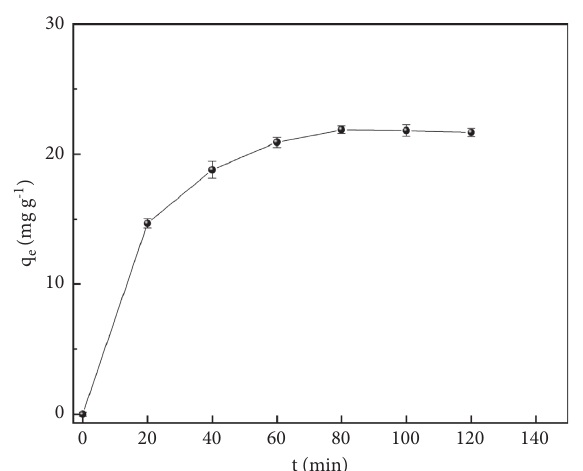
Figure 9: Zinc adsorption kinetics on the AC/Fe